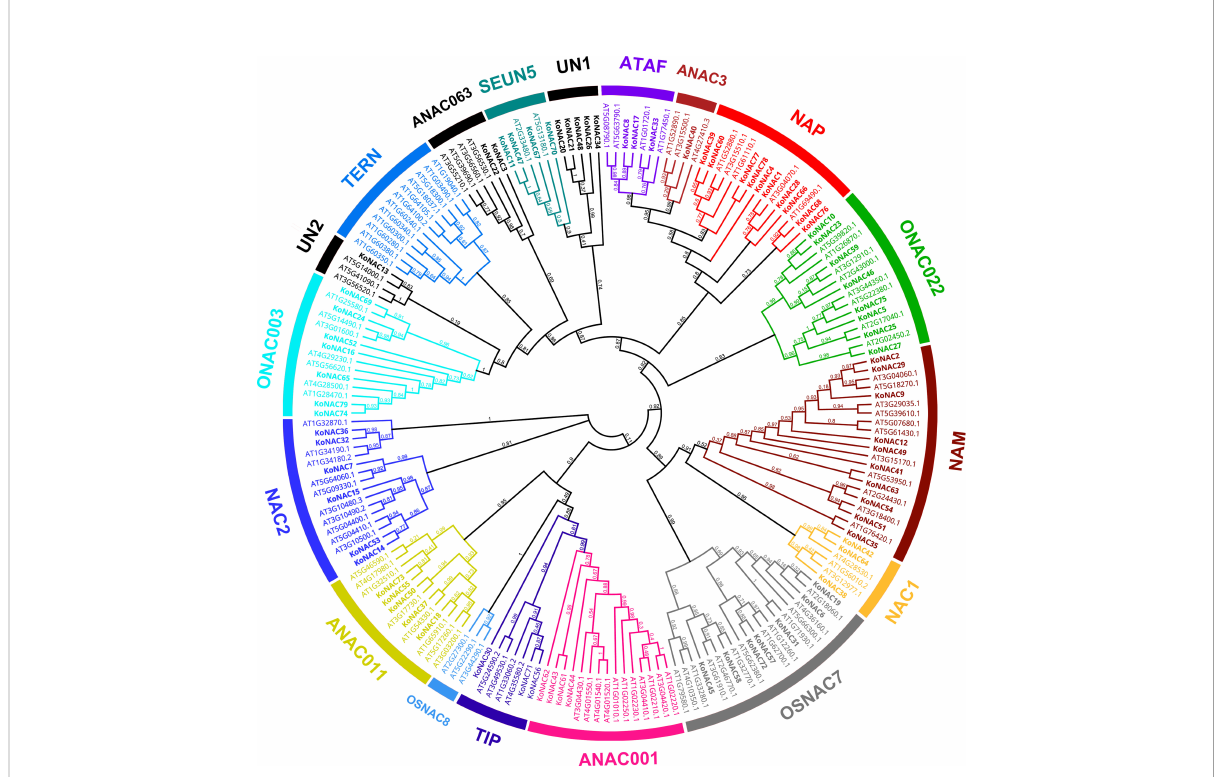
FIGURE 1 Phylogenetic relationships among NAC proteins identi fi ed in Kandelia obovata and Arabidopsis thaliana . The neighbor-joining (NJ) unrooted phylogenetic tree was constructed according to the NAC protein sequences of K. obovata and A. thaliana using the program MEGA 6.0. The subfamilies are labeled and indicated with different colors, and the unclassi fi ed KoNACs are represented by the abbreviation “ UN ”